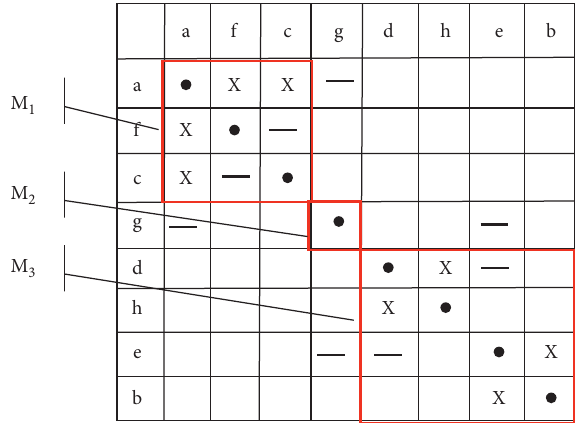
Figure 5: DSM prototype.